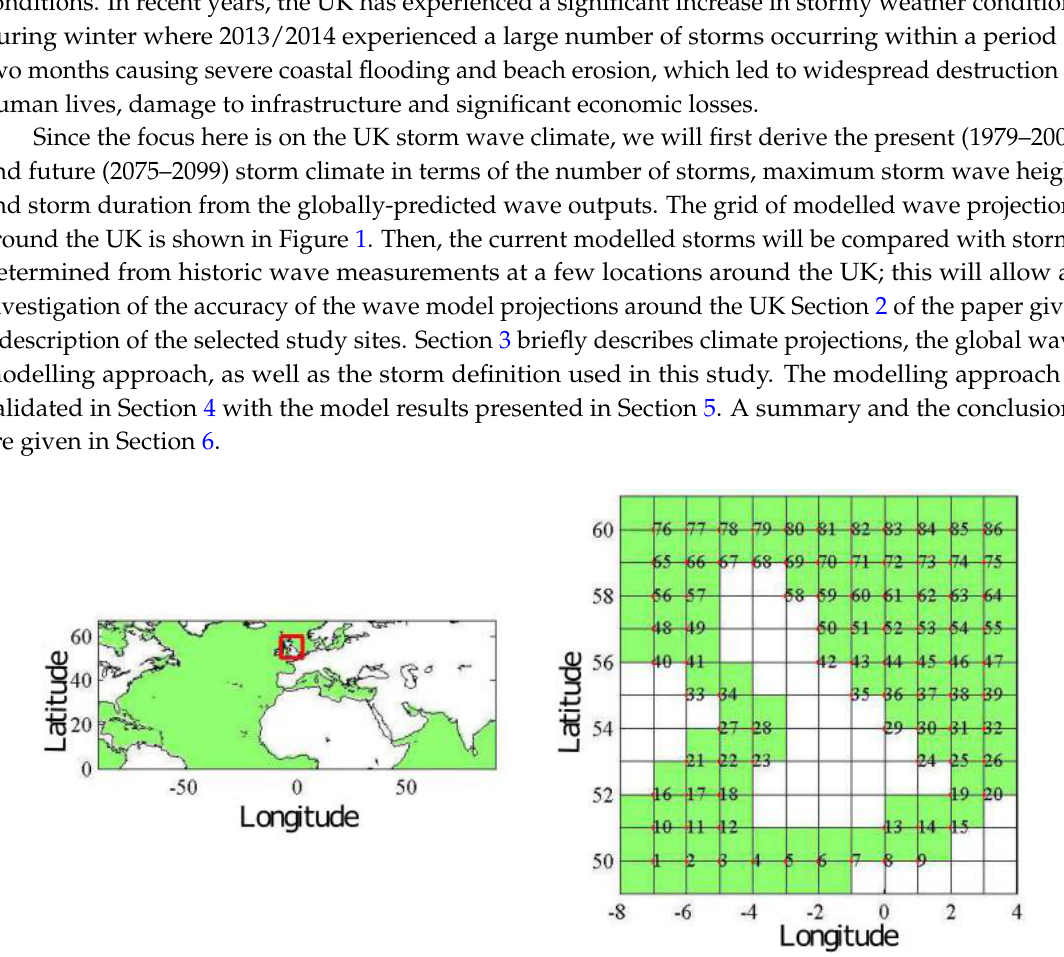
Figure 1. Wave model outputs for the UK region.